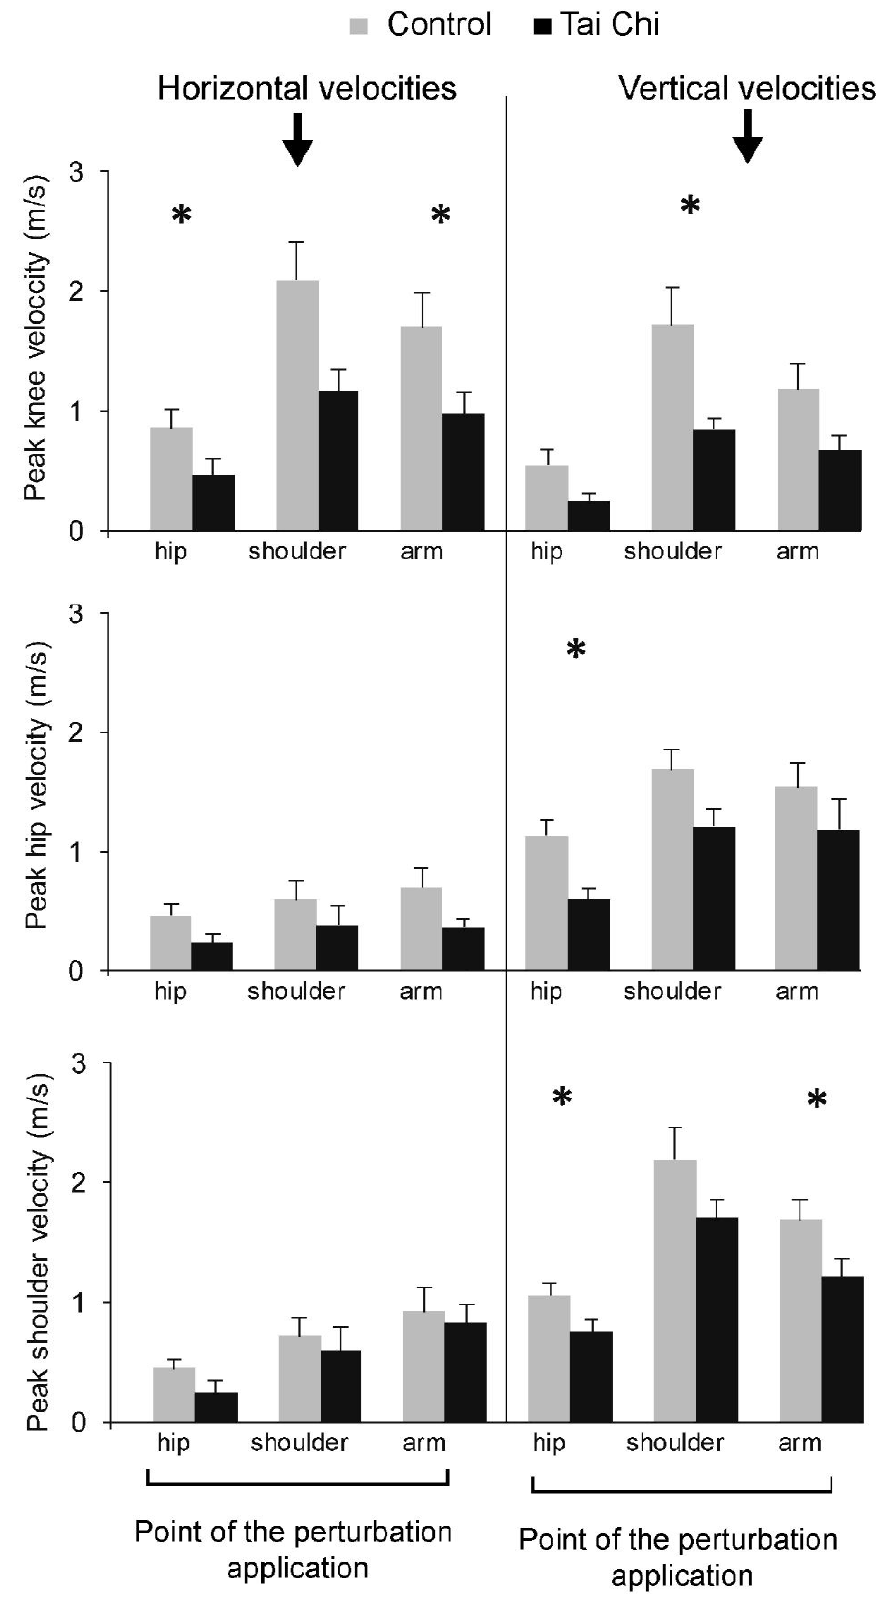
Figure 5. Peak horizontal (left) and vertical (right) velocities at the knee (top), hip (middle), and shoulder (bottom) joints for all three perturbation areas. * denotes statistically significant differences between the groups.